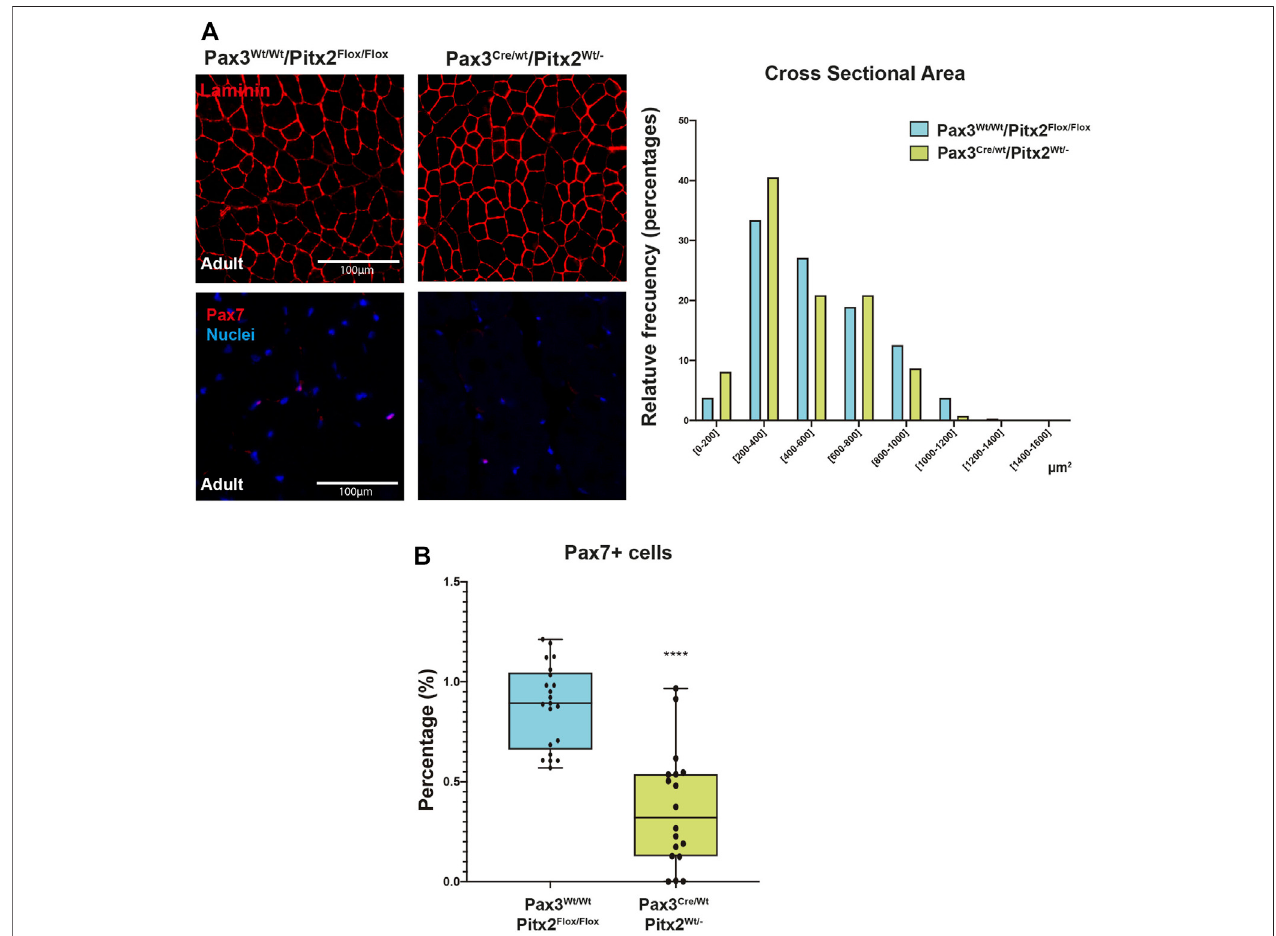
FIGURE6| Pax3 Cre/Wt /Pitx2 Wt/- conditionalmutantadultsshowreducedCSAaswellasminorpopulationofSC. (A) RepresentativeimagesofPAX7andLAMININ in the TA muscles of Pax3 Wt/Wt /Pitx2 Flox/Flox , Pax3 Cre/Wt /Pitx2 Wt/Wt and Pax3 Cre/Wt /Pitx2 Wt/- mice at adult stage (A,B) . Distribution of cross-sectional area in tibialis anterior (TA) muscles. Percentage of PAX7 + cells is shown. ** p < 0.01, **** p < 0.0001 ( n = at least 3 mice per condition).